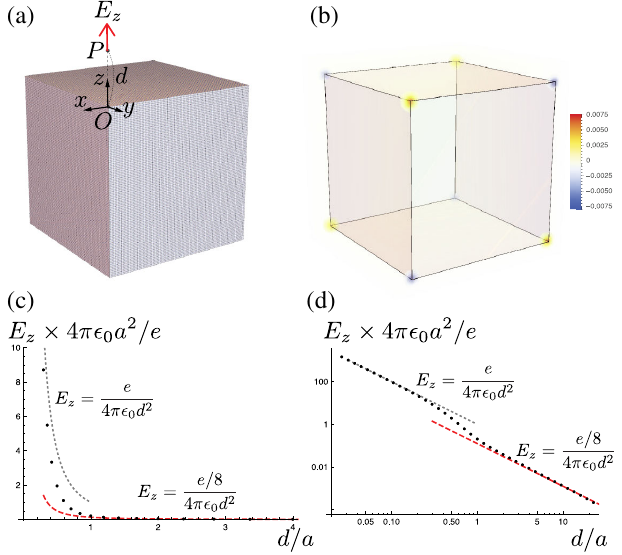
FIG. 4. (a) A cubic sample of NaCl with side length L ¼ 49 . 5 a . ð r Þ for the sample in (a). (b) The coarse-grained charge density ˜ ρ tot (c) The z component of the electric field E z at distance d above the corner O . As d increases, E z changes from the contribution of the single Na þ ion (the gray dotted curve) to the contribution of the corner charge Q c ¼ þ e= 8 (the red dashed curve). (d) The log-log plot of